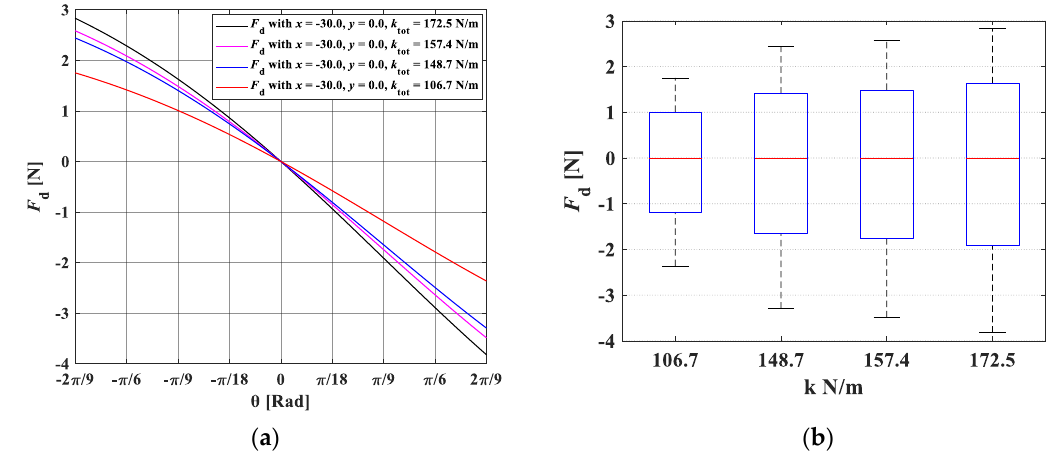
Figure 15. ( a ) Effects of compliance elements; ( b ) comparisons of compliance elements.